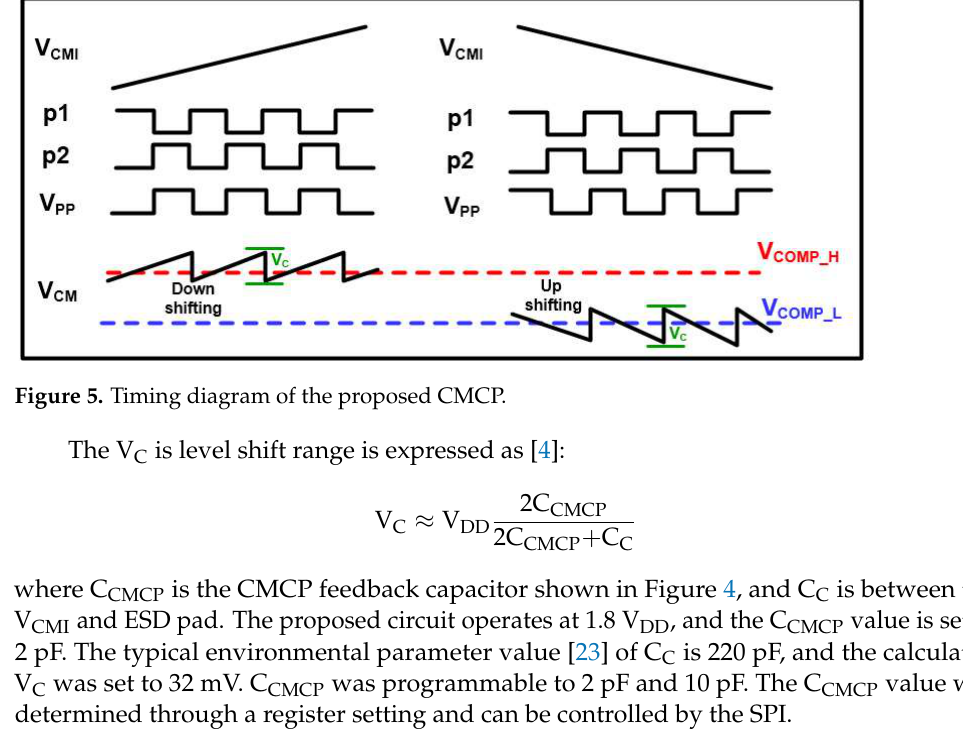
Figure 5. Timing diagram of the proposed CMCP.